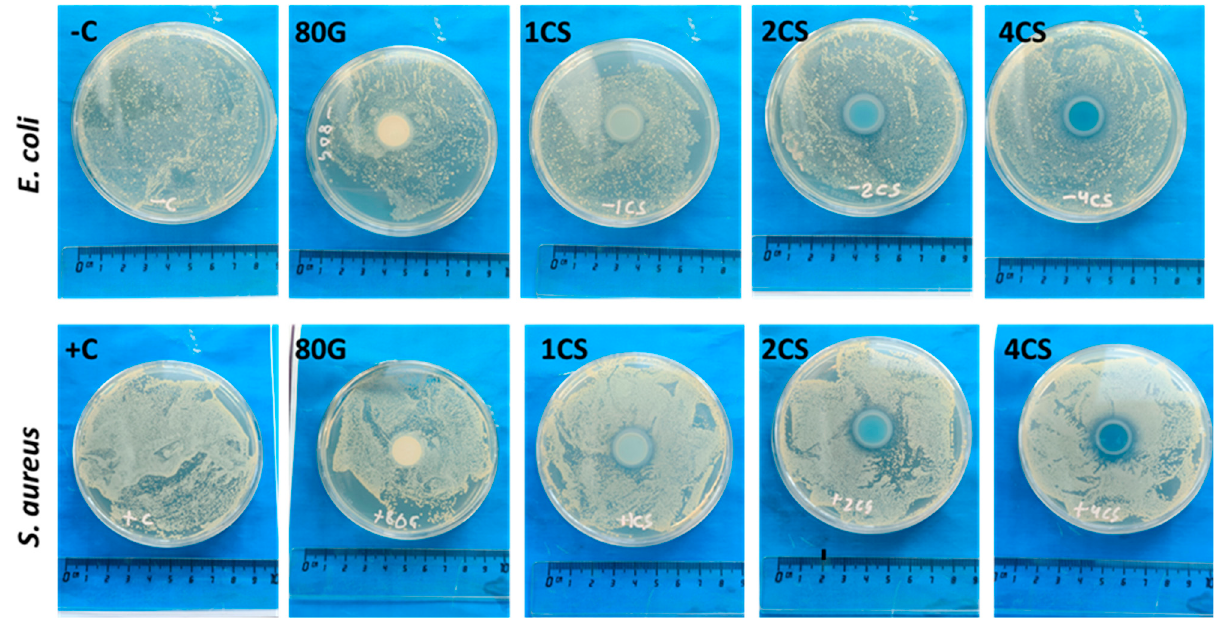
Figure 11. Photographic images of MBG pellets treated with Gram-negative ( E. coli ) and Gram-positive ( S. aureus ) bacteria using the agar disk diffusion method.